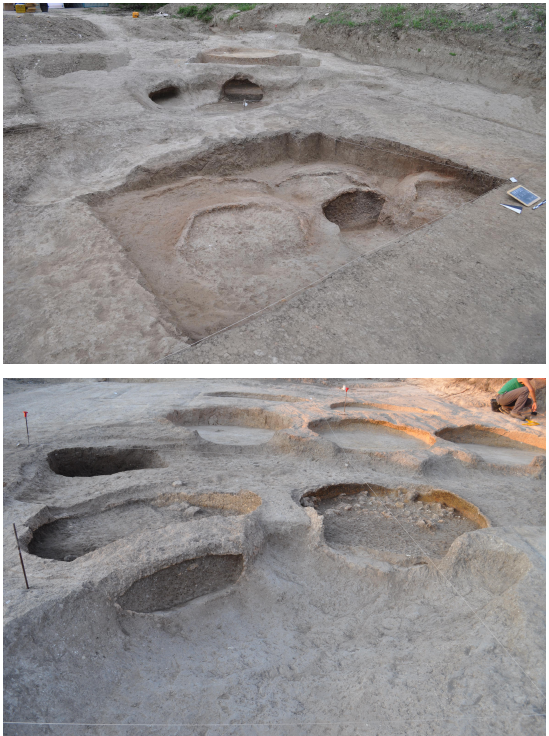
Figure 2: Archival images representing the historical evidence of the ruins, at the times of their discovery. The images show the condition of the ovens few years and then abandoned, as there is no evidence of mainte- nance to extend its functional life. Three badly preserved burials were found within two ovens, containing the remains of two in- dividuals and one adult male. This evidence clearly indicates the abandonment of the primary function of the ovens. To date we have not found any trace of a settlement connected to this site which could definitely be considered as a ”specialized” produc- tion area. Figure 3: Acquisition of images by the balloon system and fol-